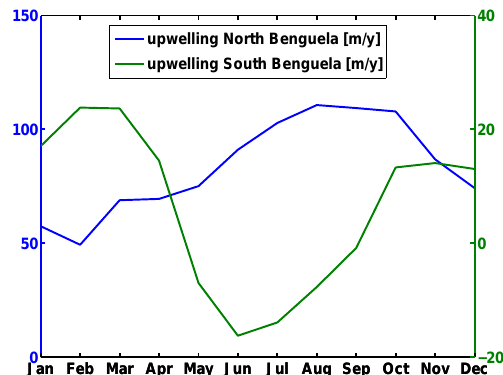
Figure 6. Annual cycle of the upwelling indices of the STORM sim- ulation derived from the simulated vertical velocity at 52m depth in North and South Benguela in the period